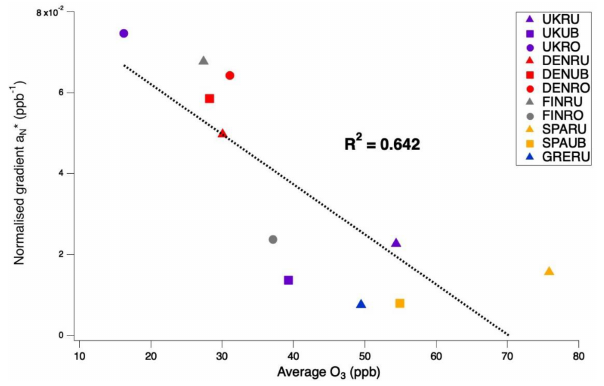
Figure 8. Relationship of average O 3 concentrations and nor- malised gradients a ∗ N